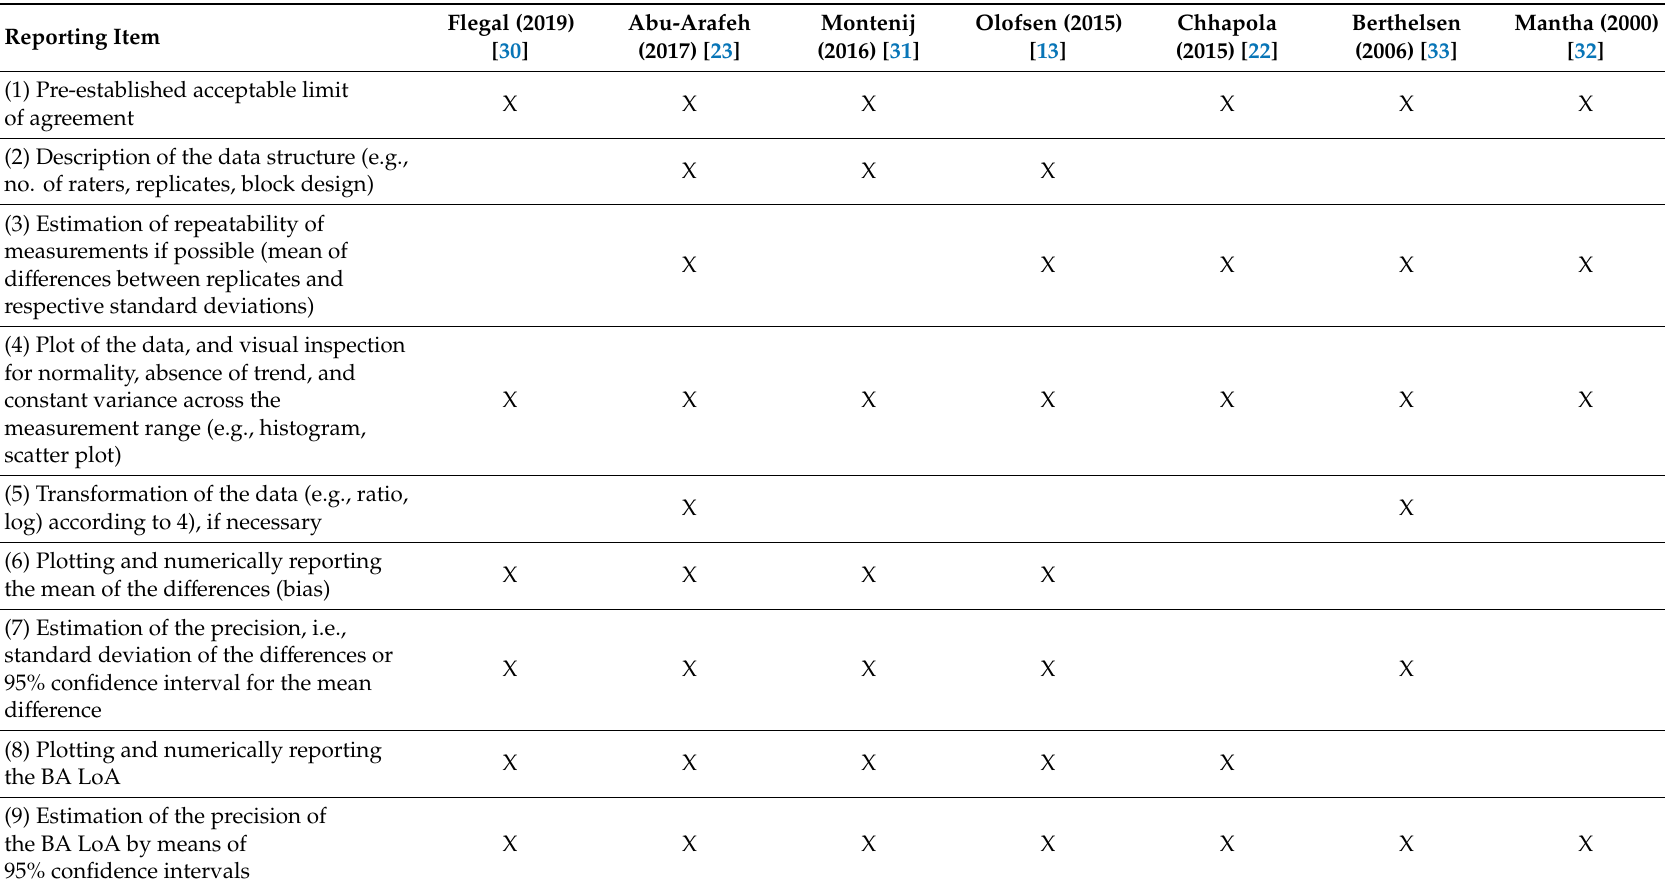
Table 2. Comparison of proposed reporting items for a Bland–Altman analysis across included